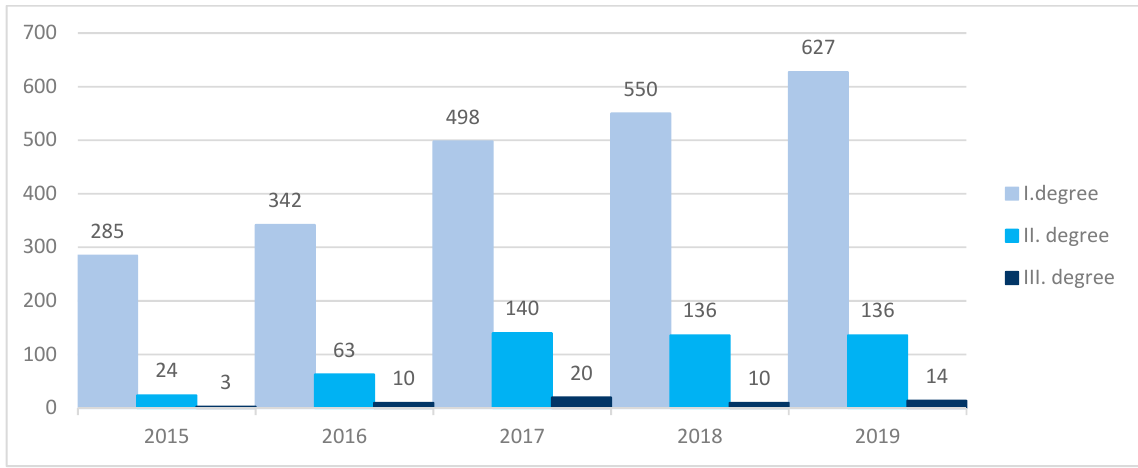
Figure 4. Graphical representation of the occurrence of floods 1., 2. and 3. degree in Slovakia from 2015 to 2019.